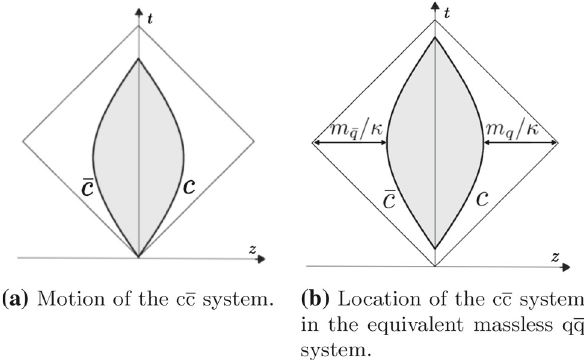
Fig. 5 The c ¯ c system and the equivalent system formed by massless q and ¯